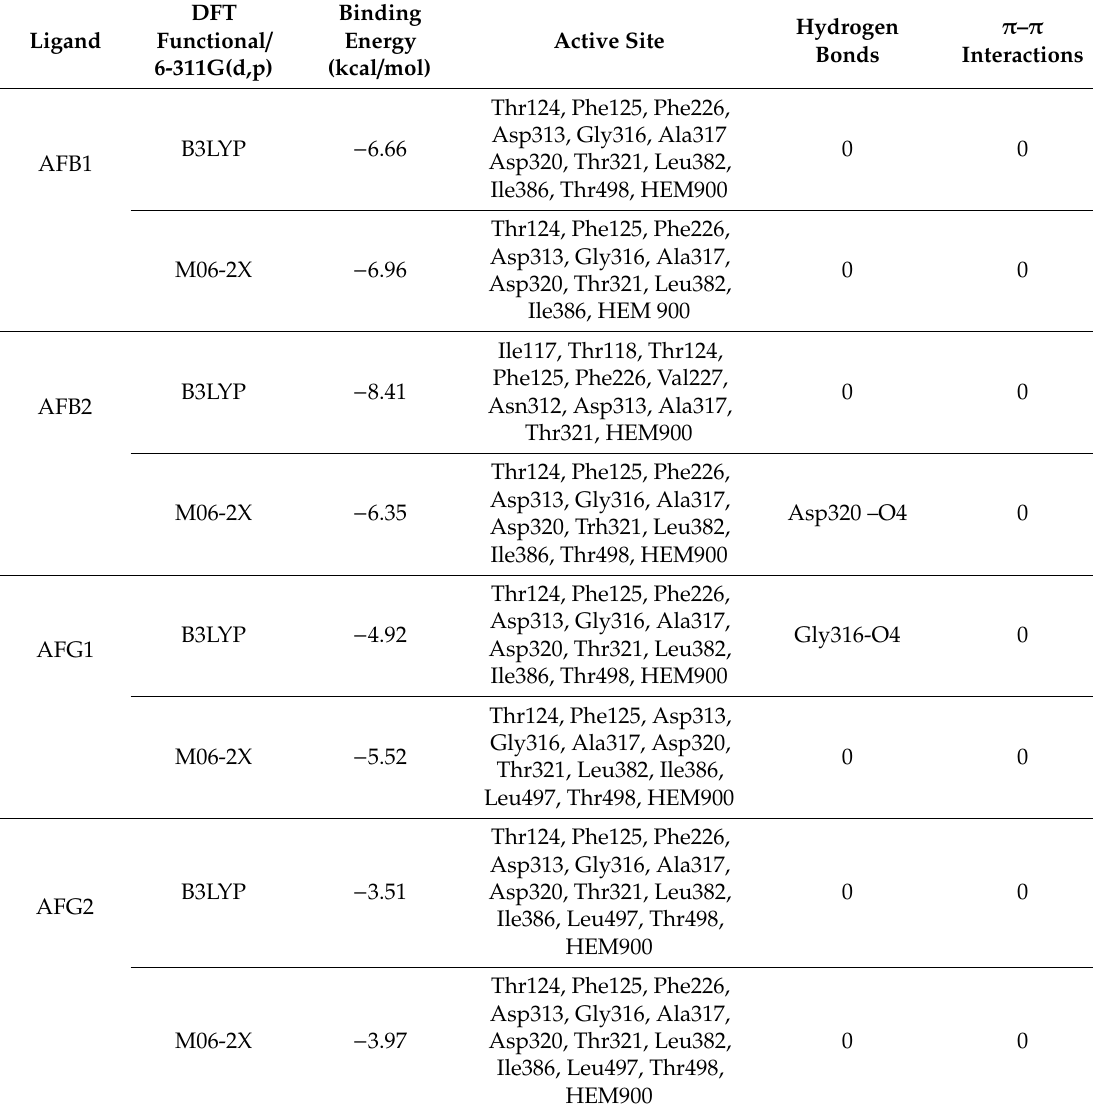
Table 3. Analysis of the molecular interactions between CYP1A2 (2HI4 PDB ID) and aflatoxins provided by molecular docking